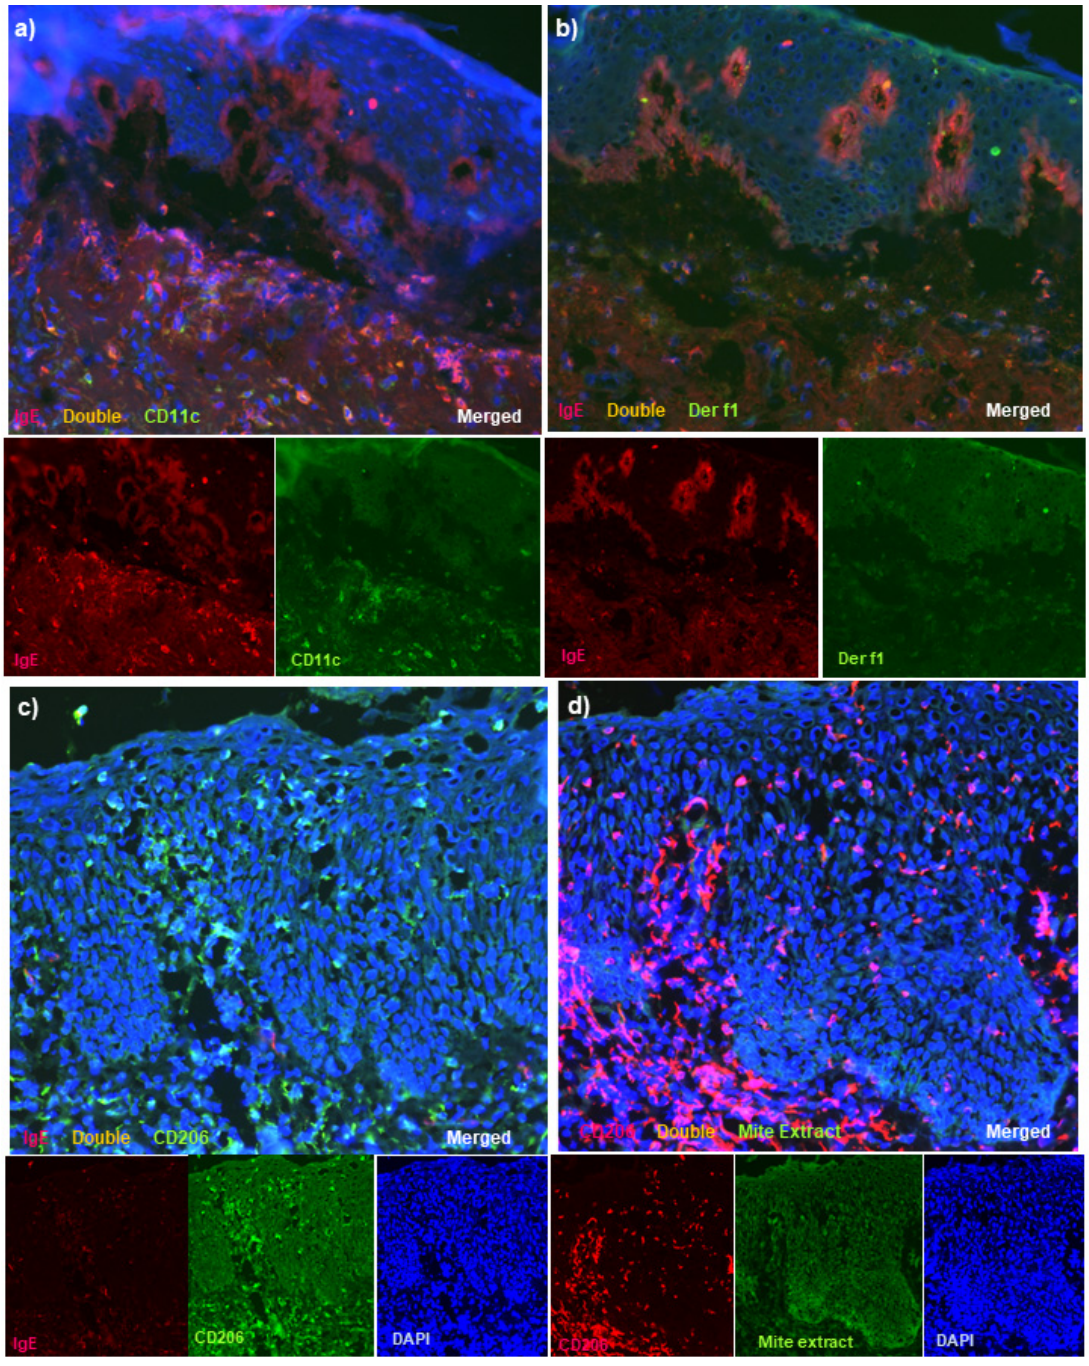
Figure 3. Double-immunofluorescence staining for skin lesions in control subjects. ( a ) In a control case of non-eczematous inflammatory skin disorders and serum hyper-IgE (bullous pemphigoid), double-positive IgE+ CD11c+ cells (yellow) were seen in small numbers among the infiltrated cells in the upper dermis, and they were scarcely detected in the epidermis. ( b ) In the same control case, double-positive IgE+ Der f1+ cells were not observed in the epidermis or the upper dermis. Note: in ( a , b ), linear depositions of IgE at the basal layer (red) were characteristically observed. ( c ) In a control case of inflammatory skin disorders and spongiotic tissue within the epidermis (nummular eczema), single-positive IgE-CD206+ cells (green) were observed in the spongiotic epidermis. ( d ) In the same control case, infiltrating CD206+ cells were scarcely detected with Mite Extract antigens in the spongiotic epidermis. ( a , b ): Case 11. ( c , d ): Case 13. Note: in ( a , b ), the single-staining images of DAPI were omitted from the figures. Sets of figures, i.e., ( a – d ), represent serial sections. Original magnifications: 200×, ( a – d ).